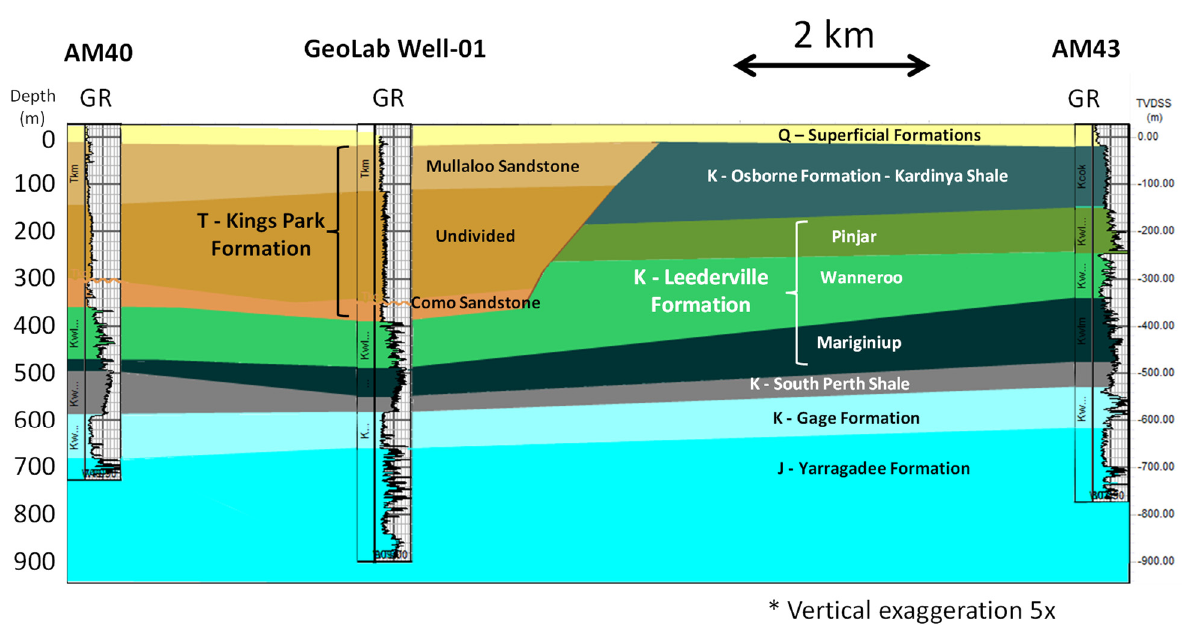
Figure 2. Geological cross-section along with three selected wells: AM40, GeoLab Well-01 and AM43.